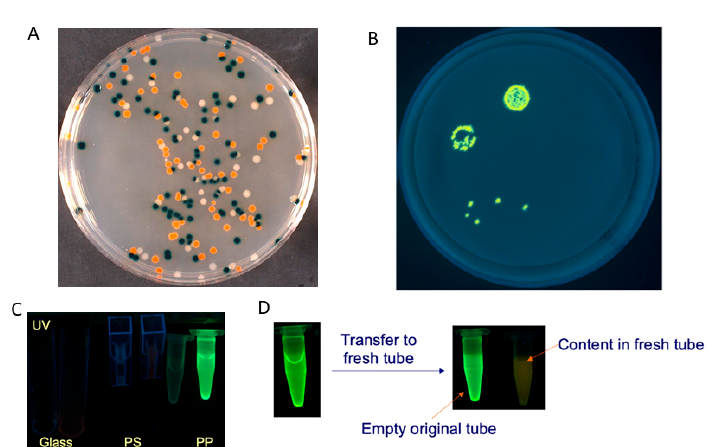
Figure 7. Structures of substrates 30 and 33 .